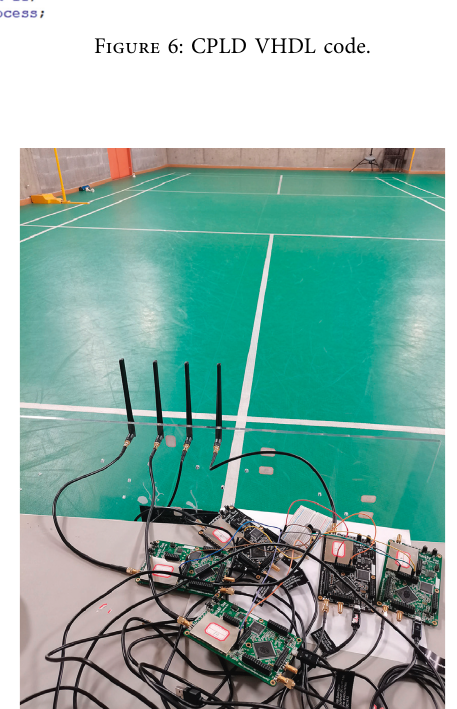
Figure 7: Experimental device.